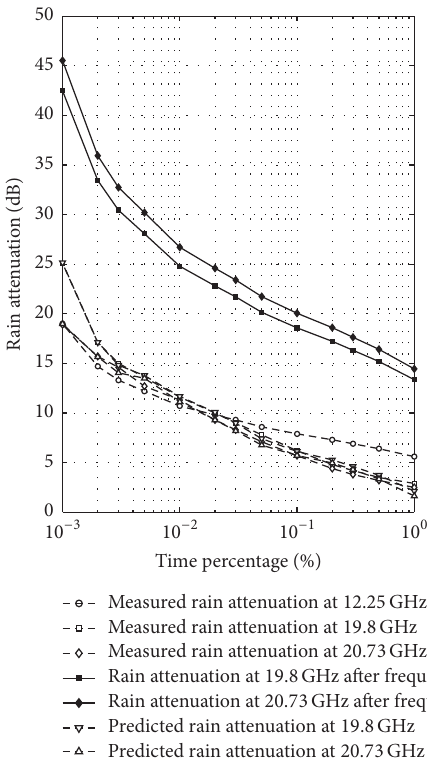
Figure 13: Cumulative distribution of calculated and estimated rain attenuation obtained after frequency scaling for combined values